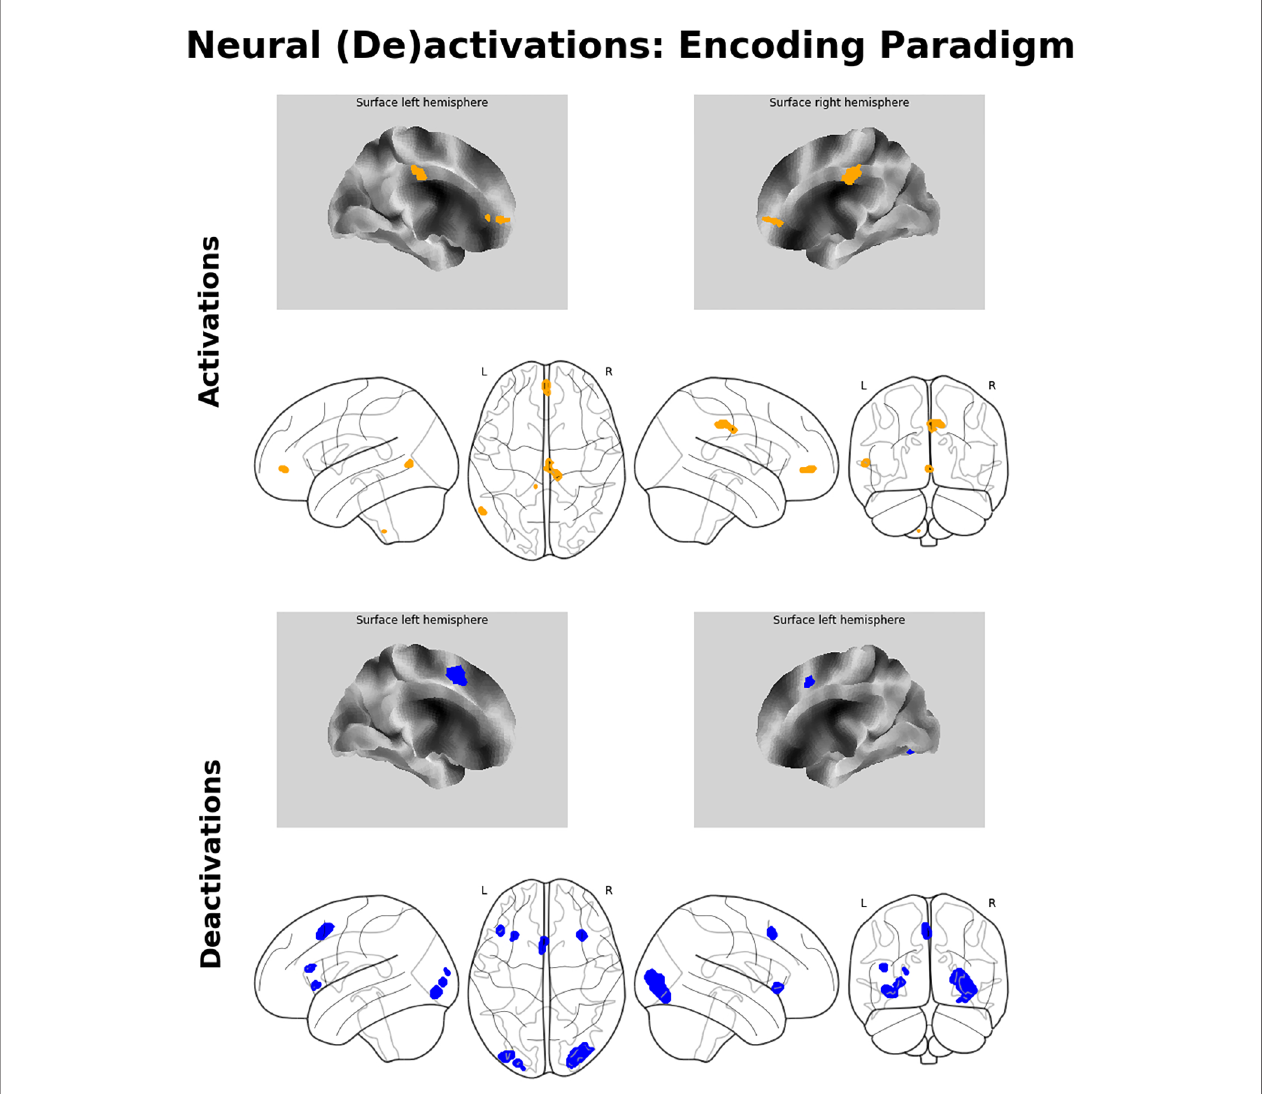
FIGURE 3 | Neuroimaging fi ndings. Medial wall surface renderings and glass brain images of brain activations (orange) and deactivations (blue) related to memory encoding. Depicted (de-)activations were thresholded at p FWE < 0.05 at peak level with a minimum cluster size of 15 contiguous